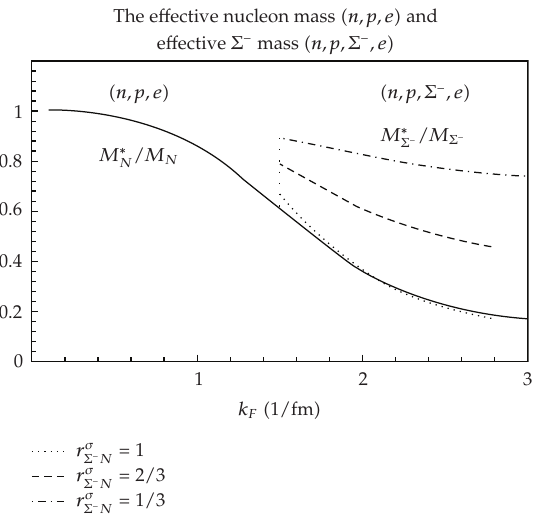
Figure 3: The e ff ective masses of N and Σ − . Note that the e ff ective mass of hyperon shows M ∗ Σ − / M Σ − ∼ 1 (cid:5) 1 / 3. The smaller coupling ratios mean less density-dependent interactions for the hyperon. as r σ Σ − N